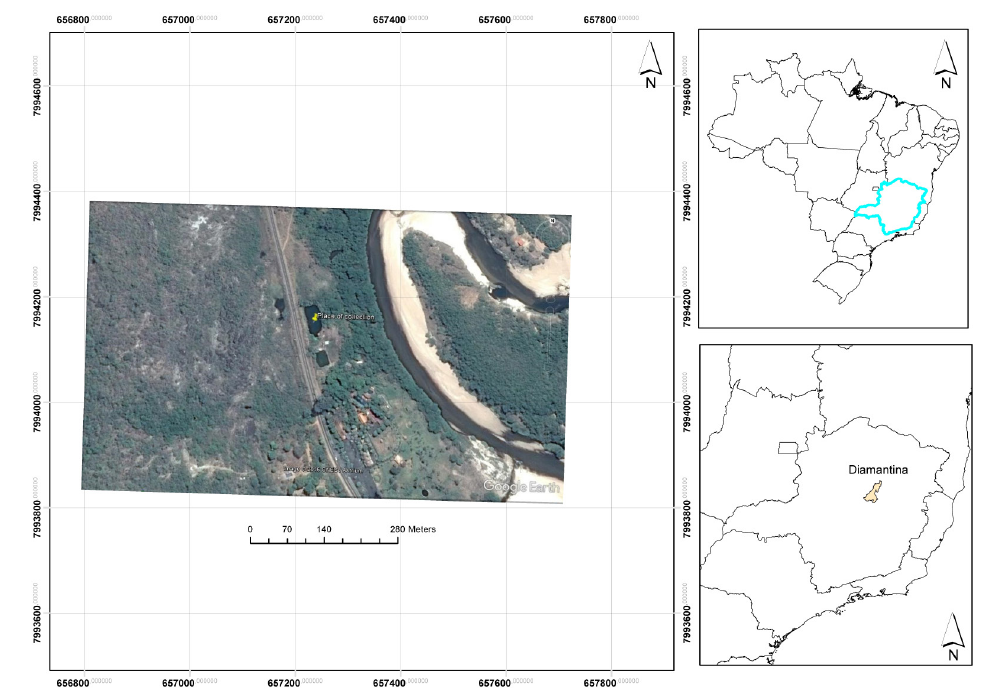
Figure 1. Area of collection of P. stratiotes at Diamantina, Minas Gerais State,